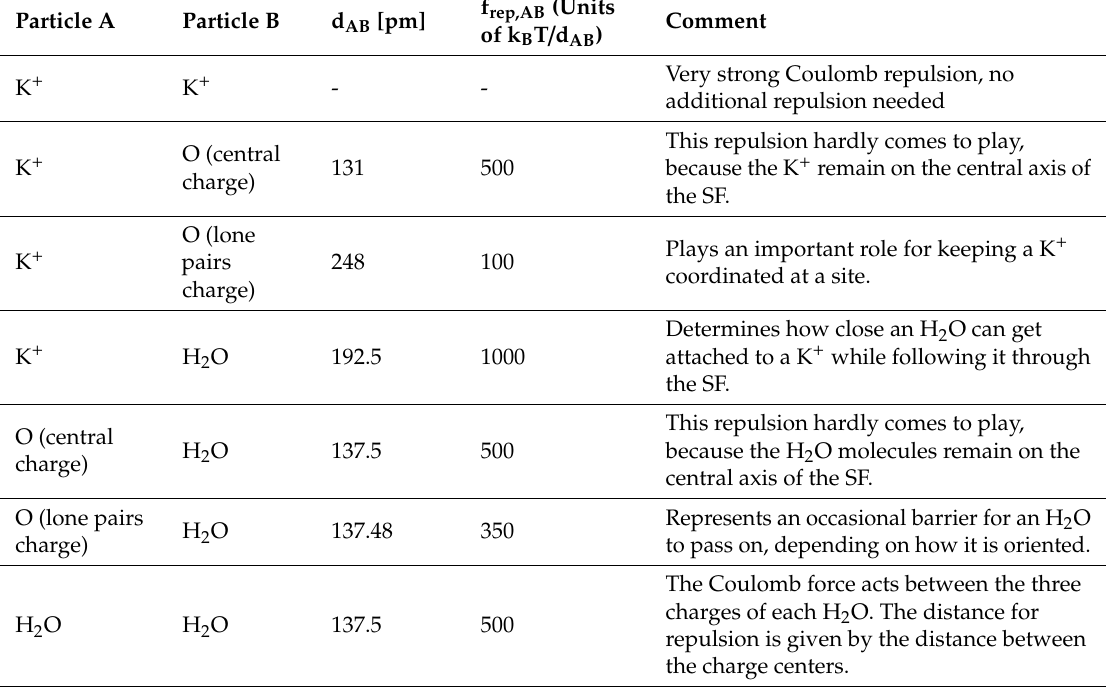
Table A1. Distances d AB between particles where constant repulsive forces set in, and